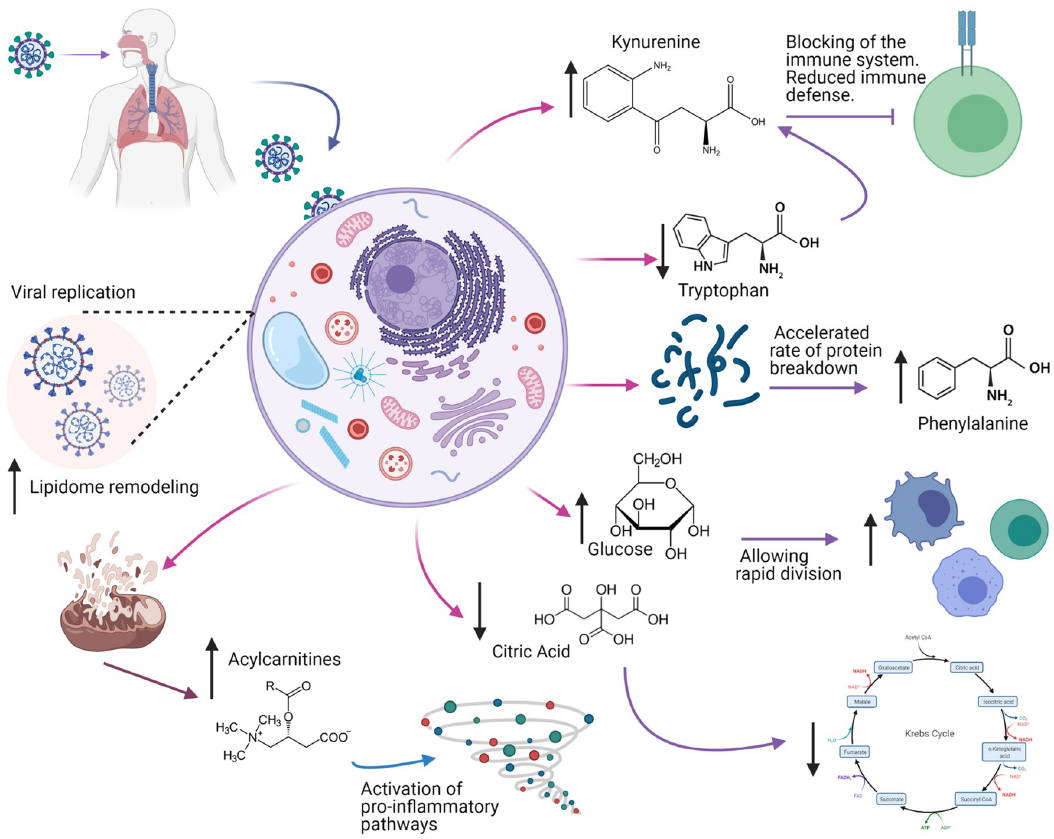
Fig 5. Differential metabolites involved in sepsis associated to COVID-19 infection. Black arrows represent the trend (increasing or decreasing) in critically ill patients. The figure was created with BioRender.com under a CC BY license, with permission from BioRender, original copyright